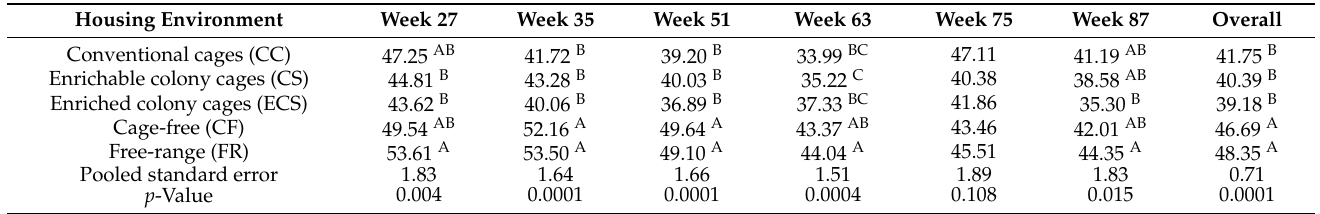
Table 8. The effect of housing environment on shell strength (N/mm 2 ) of brown egg layers by week and overall.